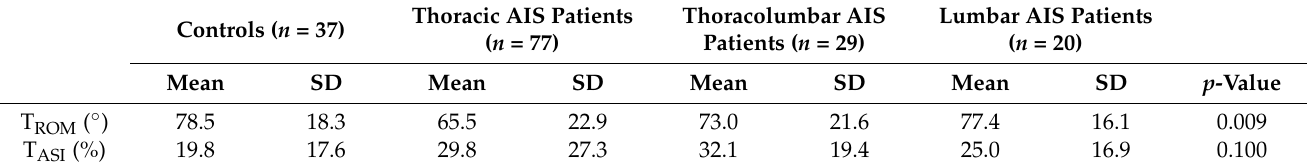
Table 5. T ROM and T ASI of thoracic, thoracolumbar, and lumbar AIS patients and controls with ANOVA p